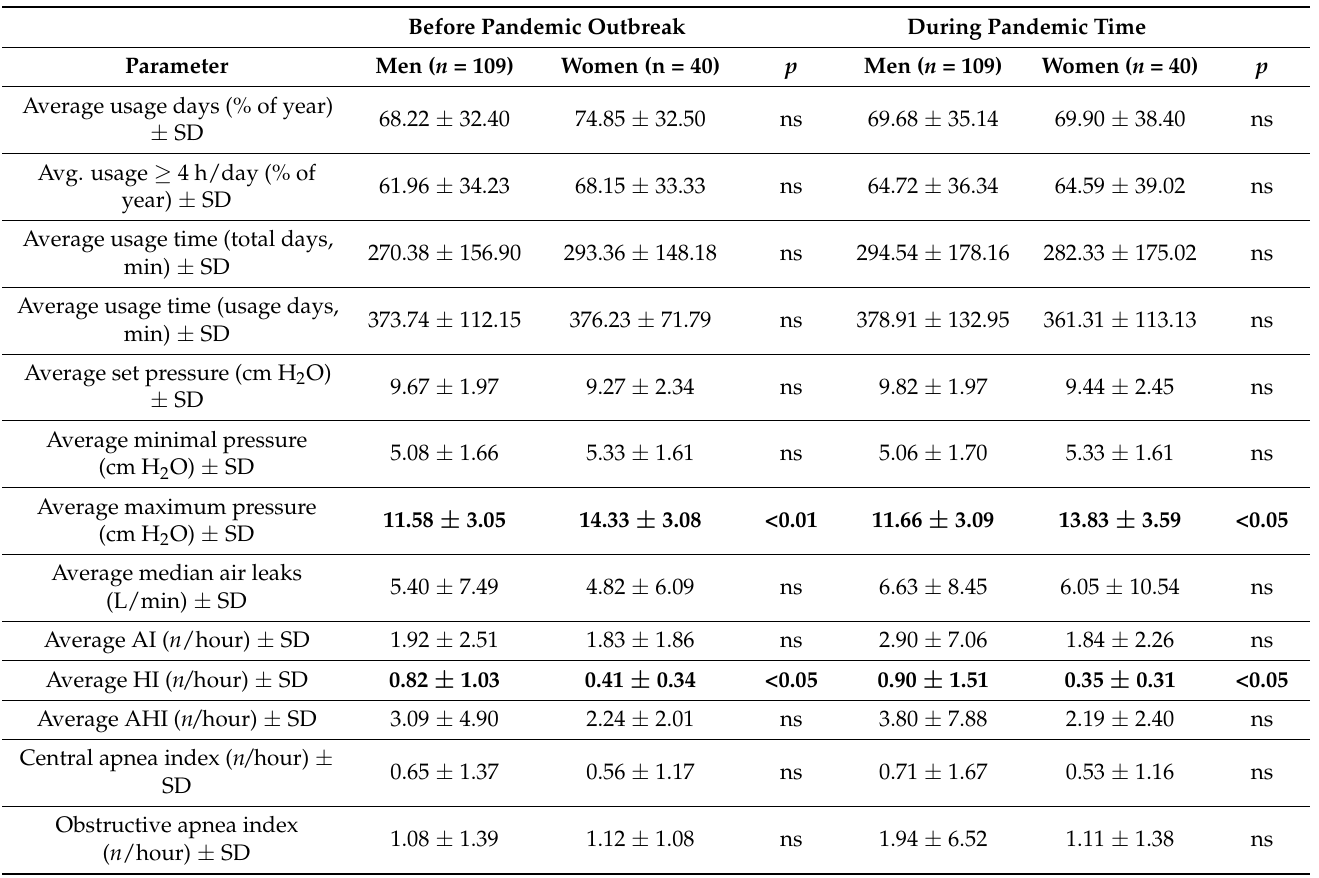
Table 2. CPAP therapy parameters and therapy adherence of male and female study participants before pandemic outbreak and during first year of pandemic time. Before Pandemic